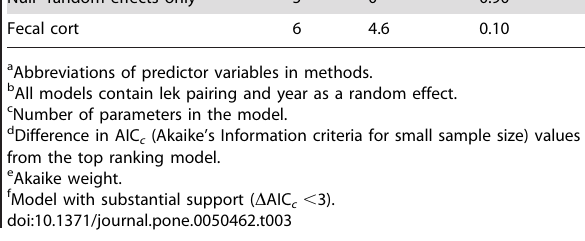
leading to a lower average noise exposure across road-noise leks